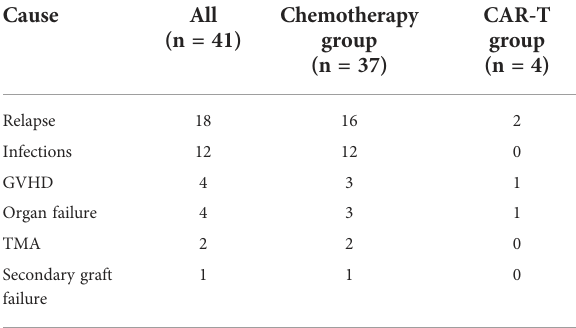
CAR-T, chimeric antigen receptor-T; GVHD, graft-versus-host disease; TMA, thrombotic